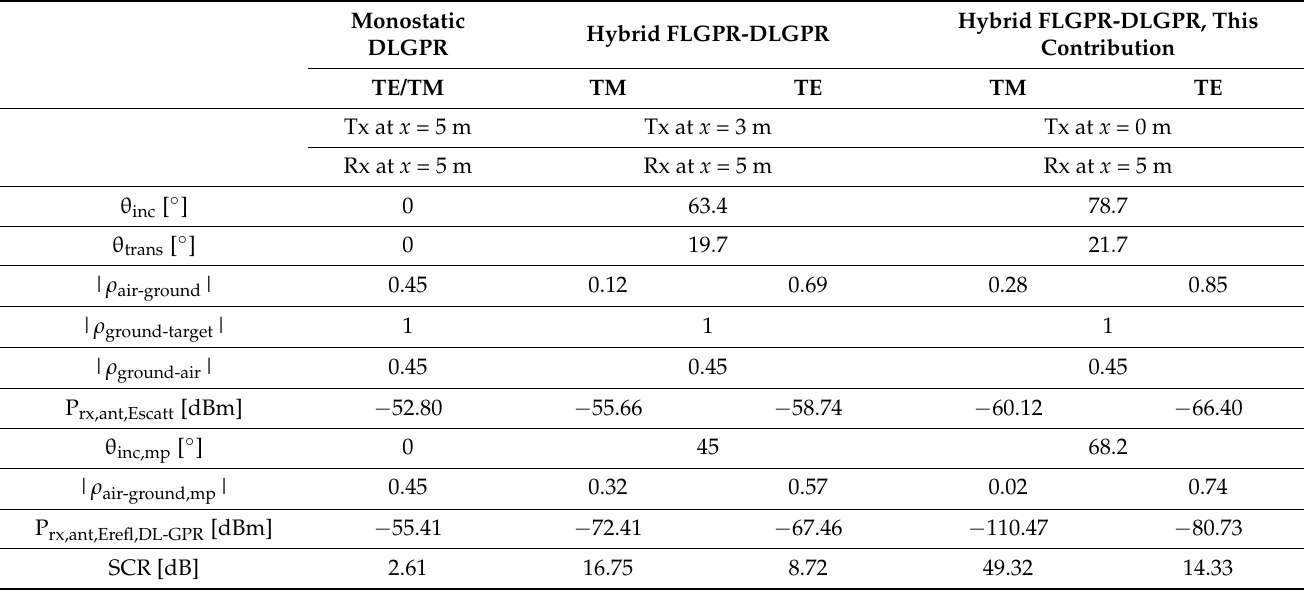
Figure 14. Scheme of the propagation model analyzed in Section 4.1. z = 0 corresponds to the air–ground interface. The Rx antenna is located at x = 5 m, z = 1 m. Table 1. Quantitative analysis of monostatic DLGPR and hybrid FLGPR-DLGPR configurations. The definition of the terms listed in the first (left) column of the table is provided in the Appendix